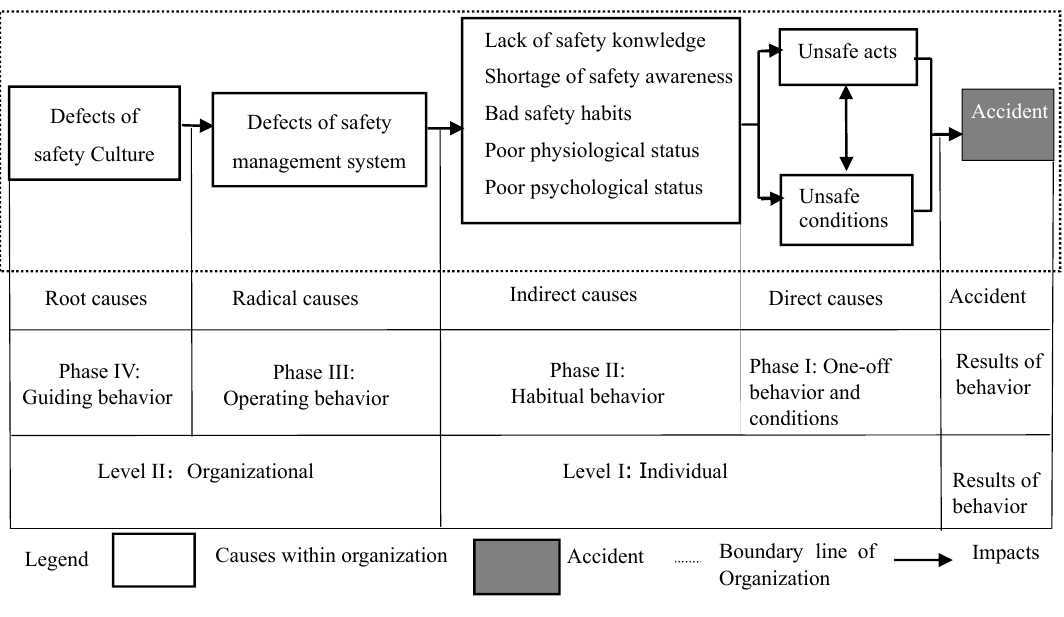
Figure 2. Correlation between safety culture, safety management and safety knowledge, safety awareness, safety habits.